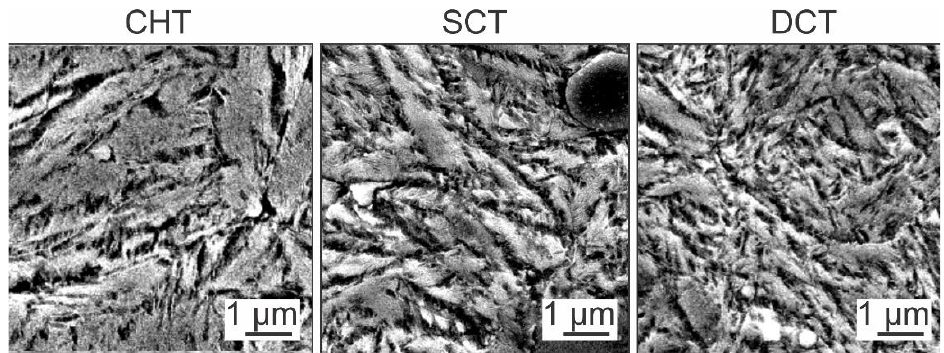
Figure 3. Enlarged SEM micrographs of the etched martensitic matrix presenting the martensitic lath refinement with shallow cryogenic treatment (SCT) and deep cryogenic treatment (DCT) compared to conventional heat treatment (CHT).